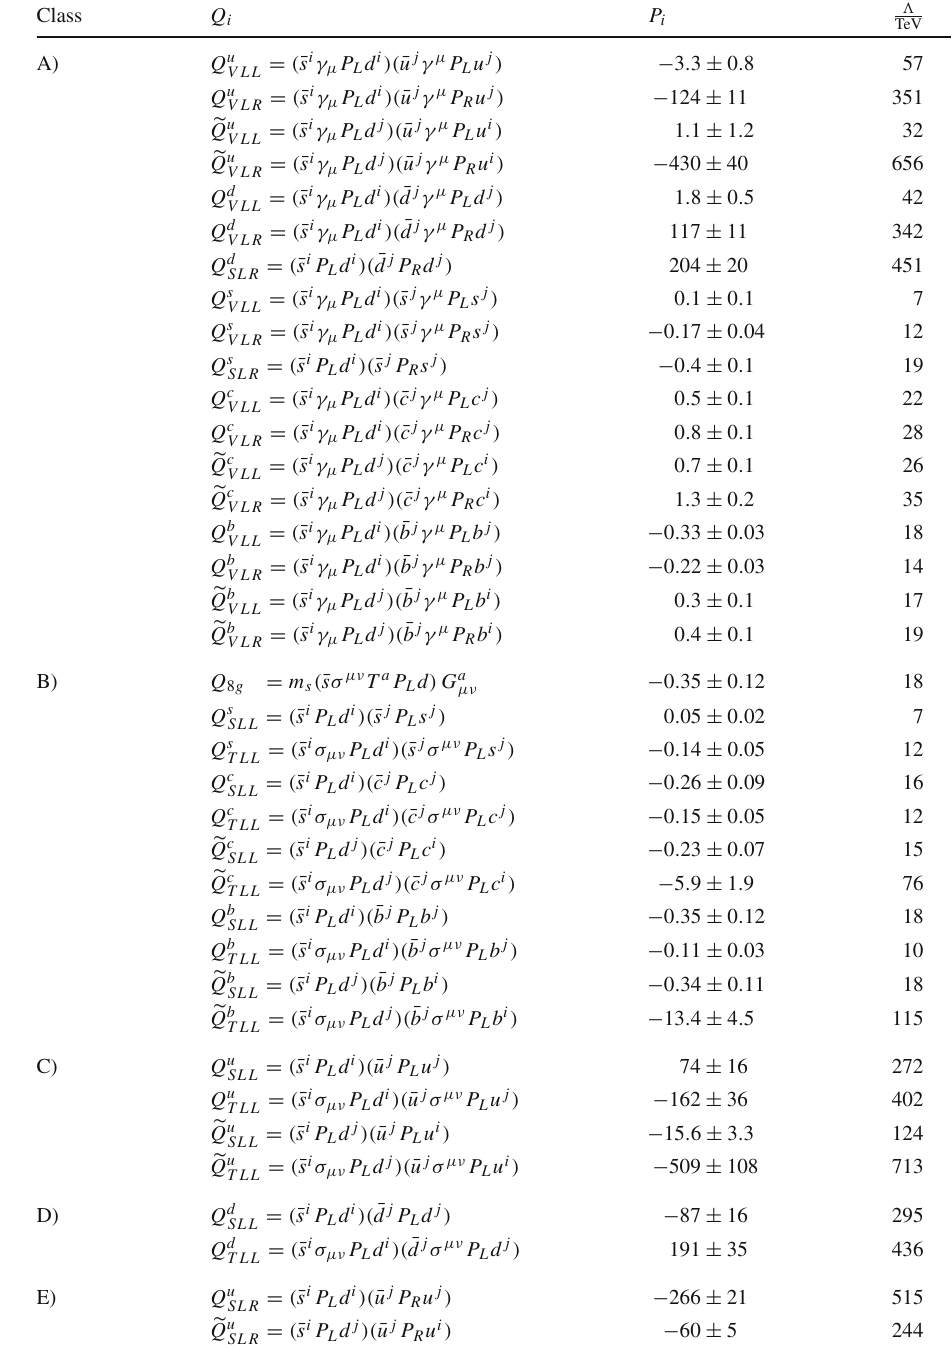
Table 4 Updated P i coefficients entering the master formula for NP effects in ε (cid:2)